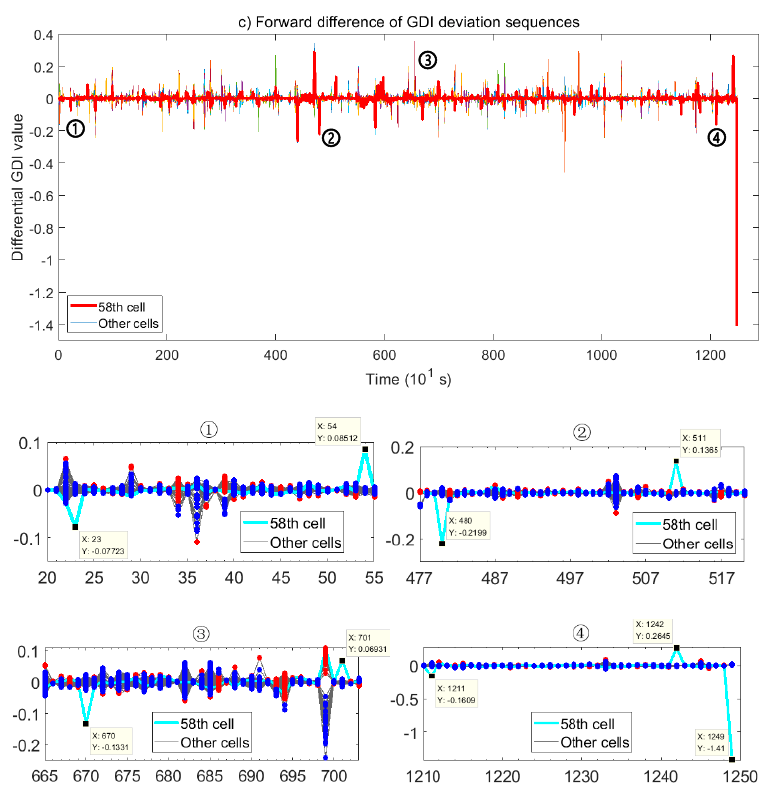
Figure 8. From the pre-fault dataset in the second case, ( a ) Sequences of Pearson correlation coefficients; ( b ) Sequences of the entropy of normalized cell voltage data; subplots: Zoom-in of 4 concerned parts; ( c ) Forward difference of the GDI deviation sequences; subplots: Zoom-in of 4 corresponding under-voltages, with the points in different temporal clusters marked in red or blue.